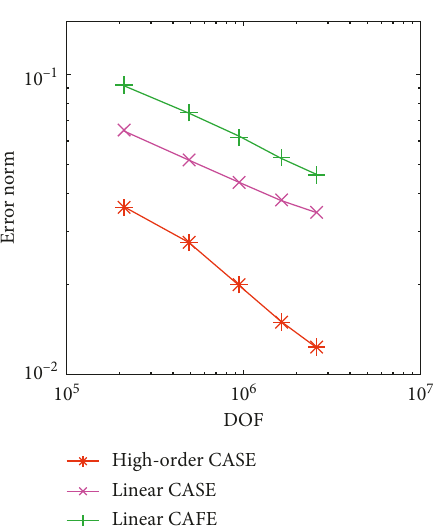
Figure 11: Error norm comparison for different element types with respect to DOF.